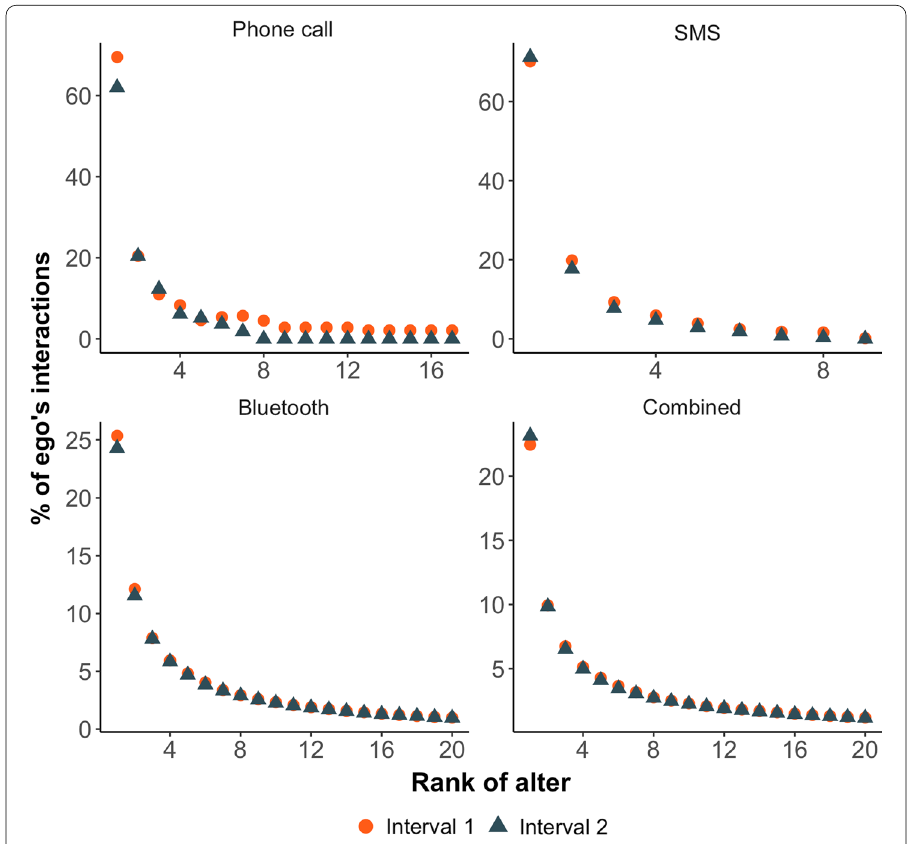
Fig. 2 The social signatures are averaged over the participants for two consecutive intervals. The shape of the social signatures is invariant across different communication